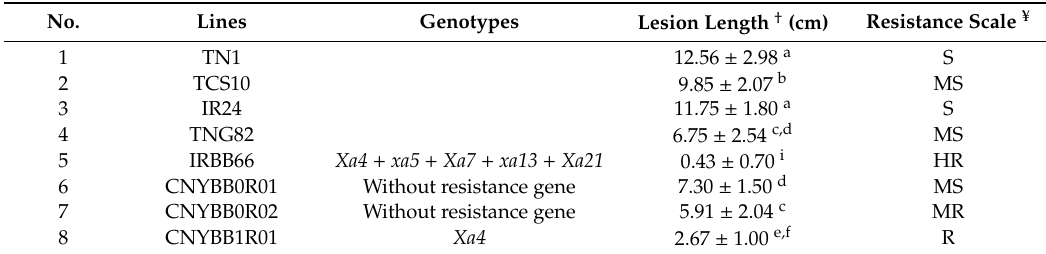
Table 1. The results of TNG82 / IRBB66 BC 2 F 3 lines after incubating the Xoo strains XF89-b in the field at the first crop season in 2016.